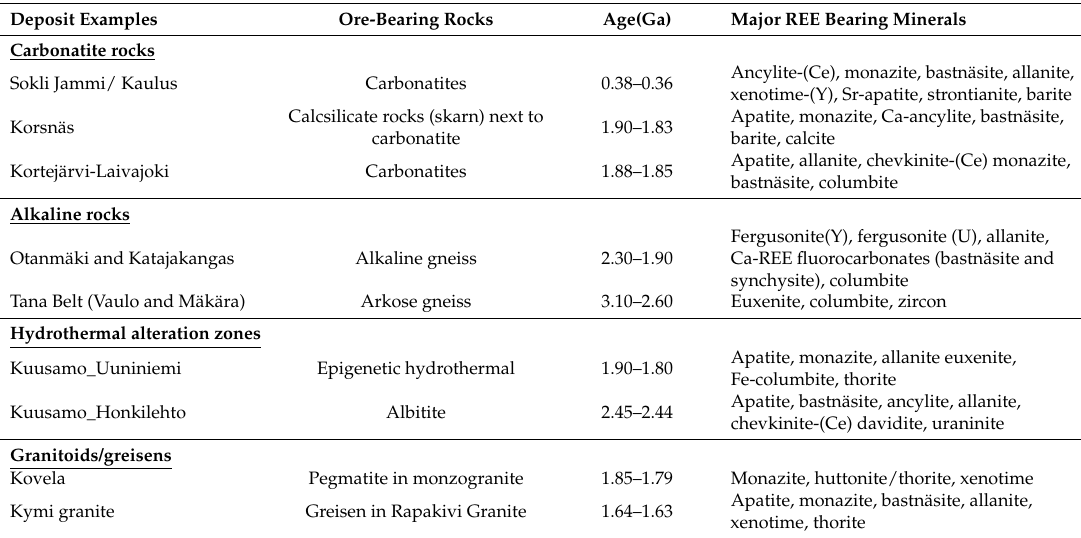
Table 1. Types of significant REE occurrences in